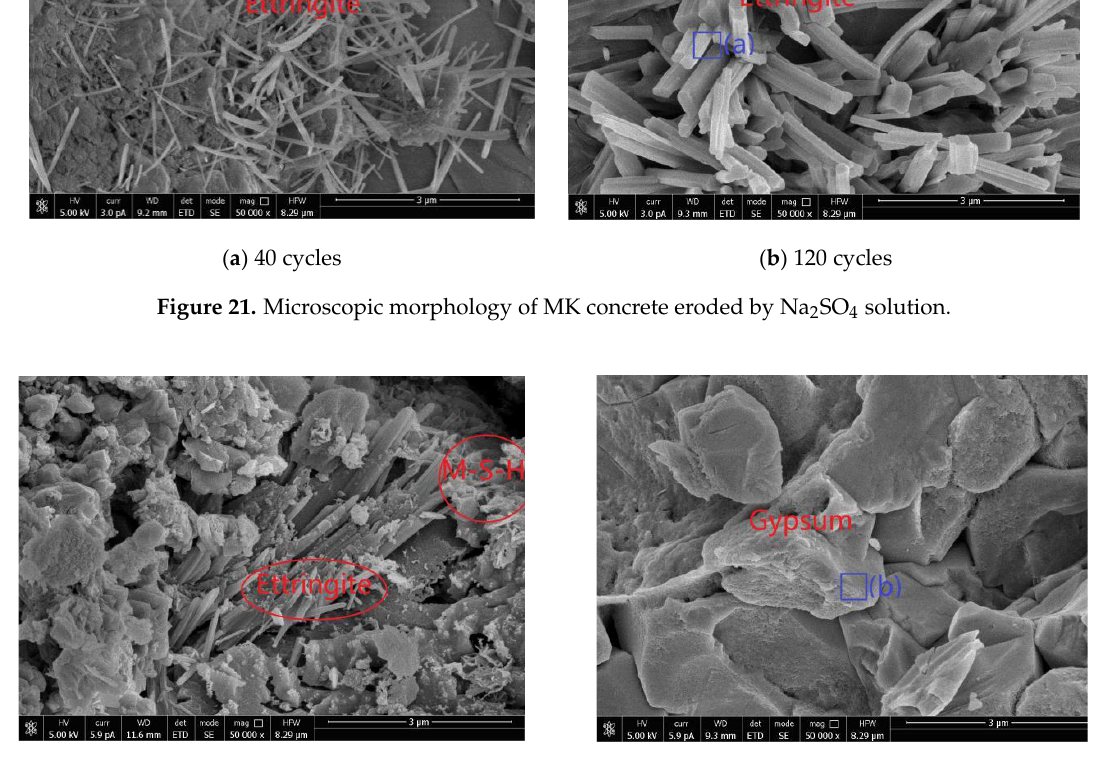
Figure 22. Microscopic morphology of MK concrete eroded by MgSO 4 solution.